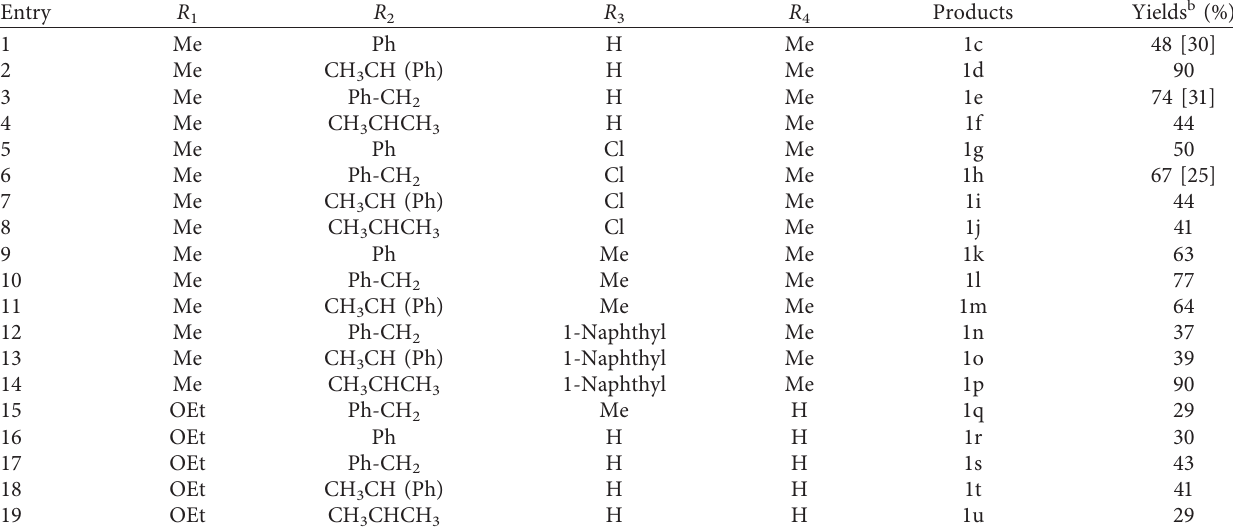
Table 3: Multicomponent synthesis of pyrroles by various substrates a